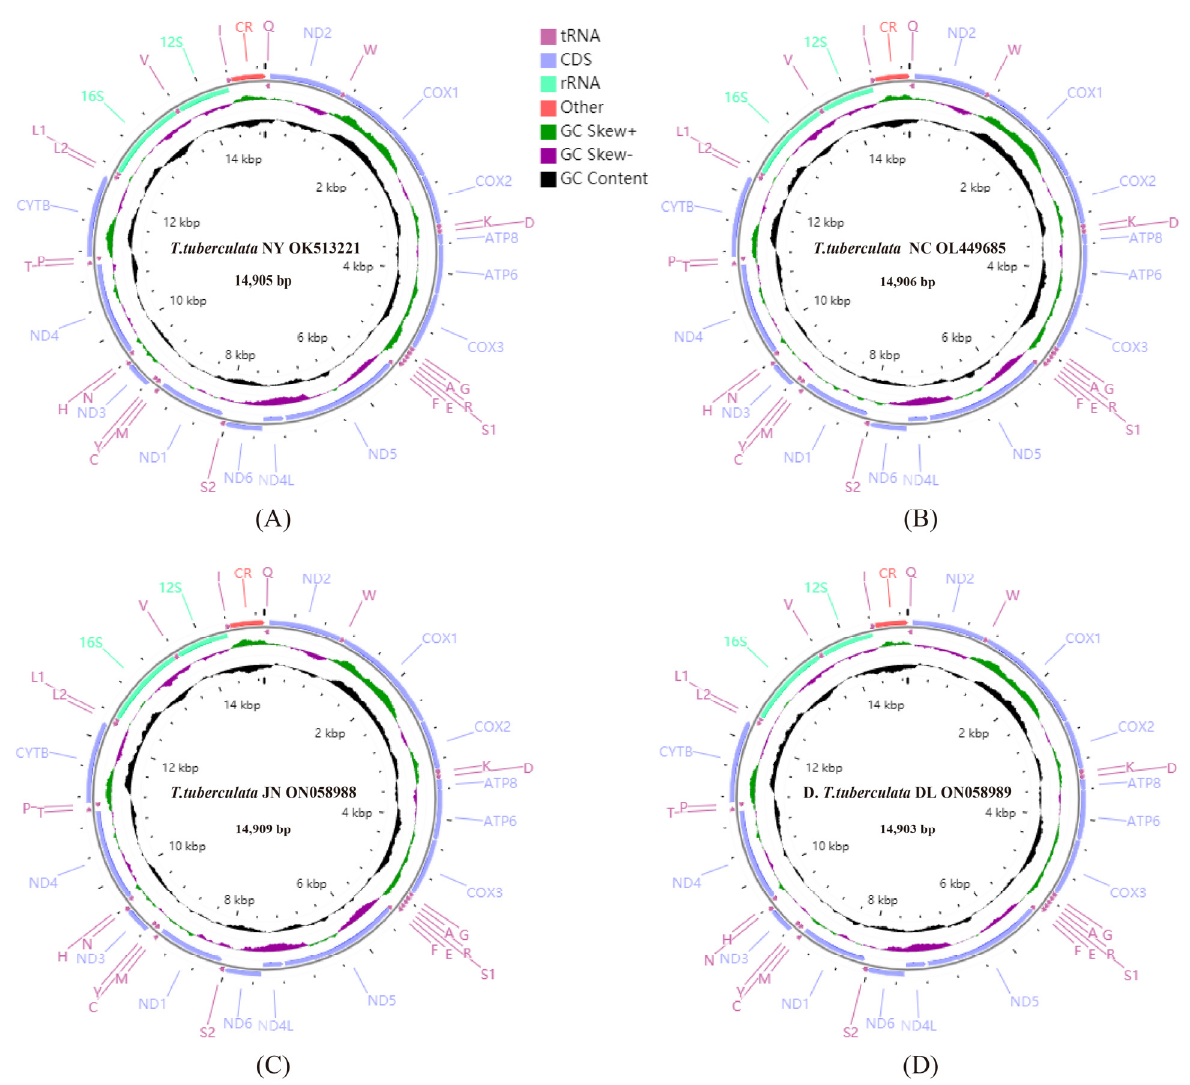
Figure 1. Mitochondrial genome maps of T. tuberculata NY ( A ), T. tuberculata NC ( B ), T. tuberculata JN ( C ), and T. tuberculata DL ( D ). The first circle shows the gene map (PCGs, rRNAs, tRNAs, and the AT-rich region). The genes shown outside the map are coded on the majority strand (J strand), whereas the genes inside the map are coded on the minority strand (N strand). The second circle shows the GC skew, and the third shows the GC content. GC content and GC skew are plotted as the deviation from the average value of the entire sequence.